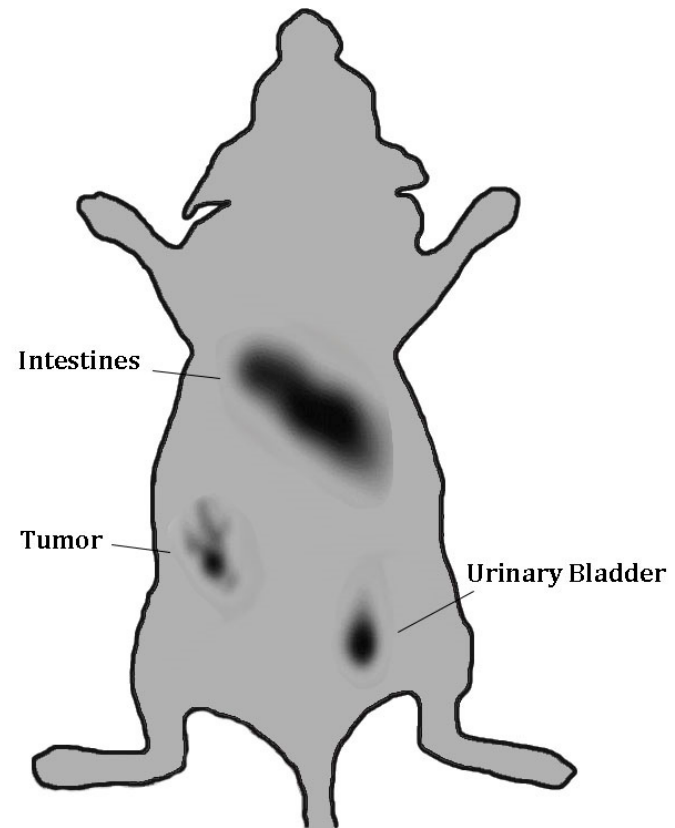
Figure 15. Gamma camera full body image of nude mouse implanted with MUC1-expressing. MCF7 Figure 15. GammacamerafullbodyimageofnudemouseimplantedwithMUC1-expressing. MCF7tumor tumor xenografts at 1 h post-injection of 99m Tc-MUC1 peptide. xenografts at 1 h post-injection of 99m Tc-MUC1